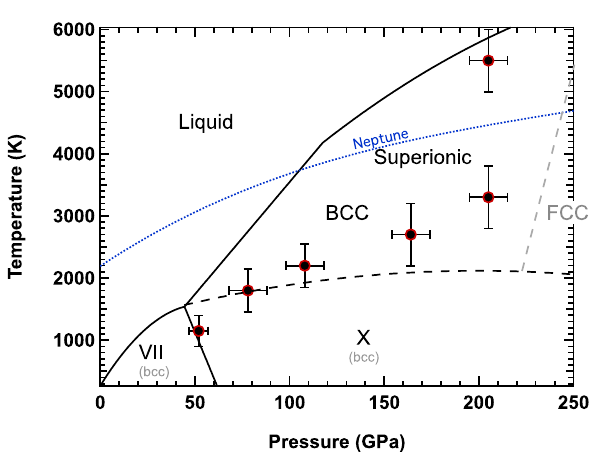
Figure 7. Lagrangian distance-time diagrams. A post-shot simulation for ( a ) pressure labeled by color code ( b ) pressure line outs of specific Lagrangian coordinates in the water layer and ( c ) temperature distribution. In ( a ) and ( c ), the red dashed line shows the water region. Solid black line in ( b ) shows drive profile. Probe time of the X-rays was at 6.95 ± 0.35 ns (orange bar) where line width includes probe time uncertainty derived from rise time of first pulse (0.15 ns) and timing jitter of laser (0.20 ns).